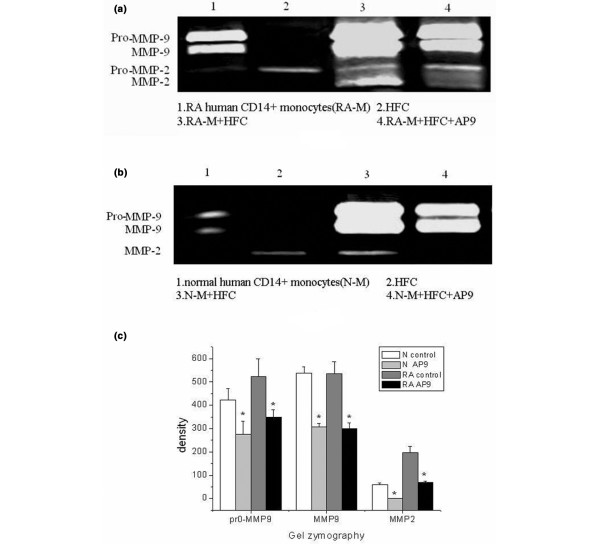
Matrix metalloproteinase (MMP) secretion in a co-culture of CD14+ monocytes and human fibroblast cells (HFC). (a) Gel zymography detection of MMP-2 and MMP-9 in human CD14+ monocytes from rheumatoid arthritis (RA) patients, in HFC and in a co-culture of the two. An elevated release and activation of MMP-9 and MMP-2 was seen in the co-culture cells compared with those in the cultures of human monocytes or HFC alone. (b) Gel zymography detection of MMP-2 and MMP-9 in human CD14+ monocytes of normal control monocytes, in HFC, and in a co-culture of the two. MMP-2 and MMP-9 release was higher in the co-culture cells. (c) Effects of antagonistic peptide 9 (AP9) on pro-MMP-9, MMP-9 and MMP-2 release in a co-culture of human CD14+ monocytes and HFC. The zymography gels above were scanned and the gray density of strips was counted. The release and activation of pro-MMP-9, MMP-9 and MMP-2 was significantly reduced when AP9 was added. Asterisks indicate a p-value <0.01. HFC, Human fibroblast cells.